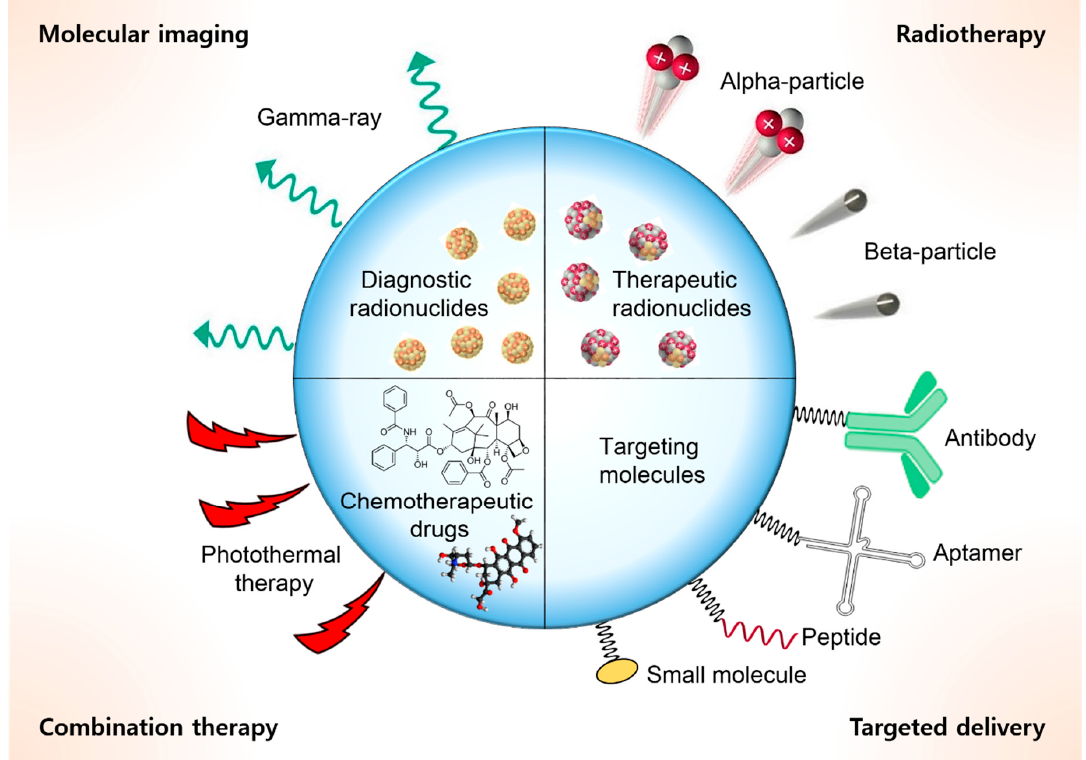
Figure 1. Multifunctional nanomaterials for therapeutic study.